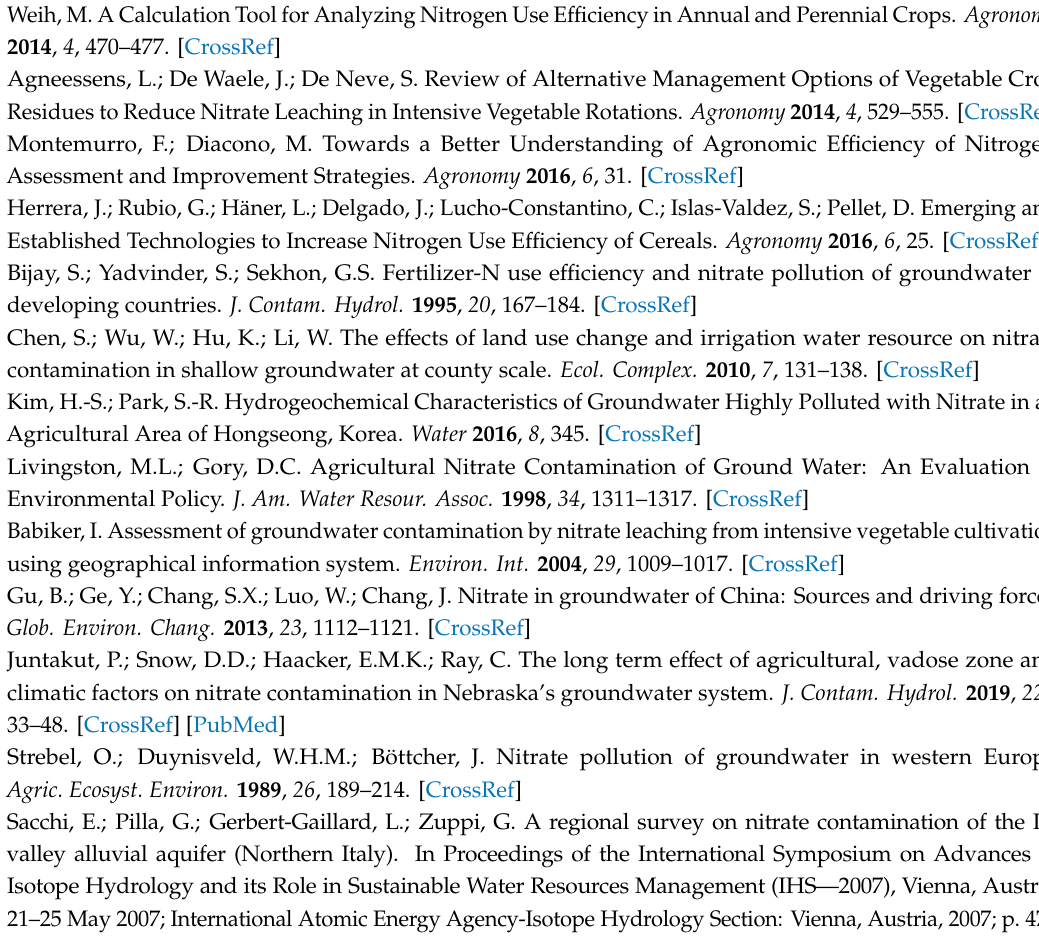
Table S1: Hydrochemical data of water samples from surface (SW) and aquifers (GW) in the western side of the Hoya de Huesca County (Spain), Table S2: Correlation matrix between main groundwater ions and electrical conductivity, Figure S1: Geological map of the area of study, according to Spanish Geological Survey’s (IGME) GEODE-Continuous digital geological map of Spain color